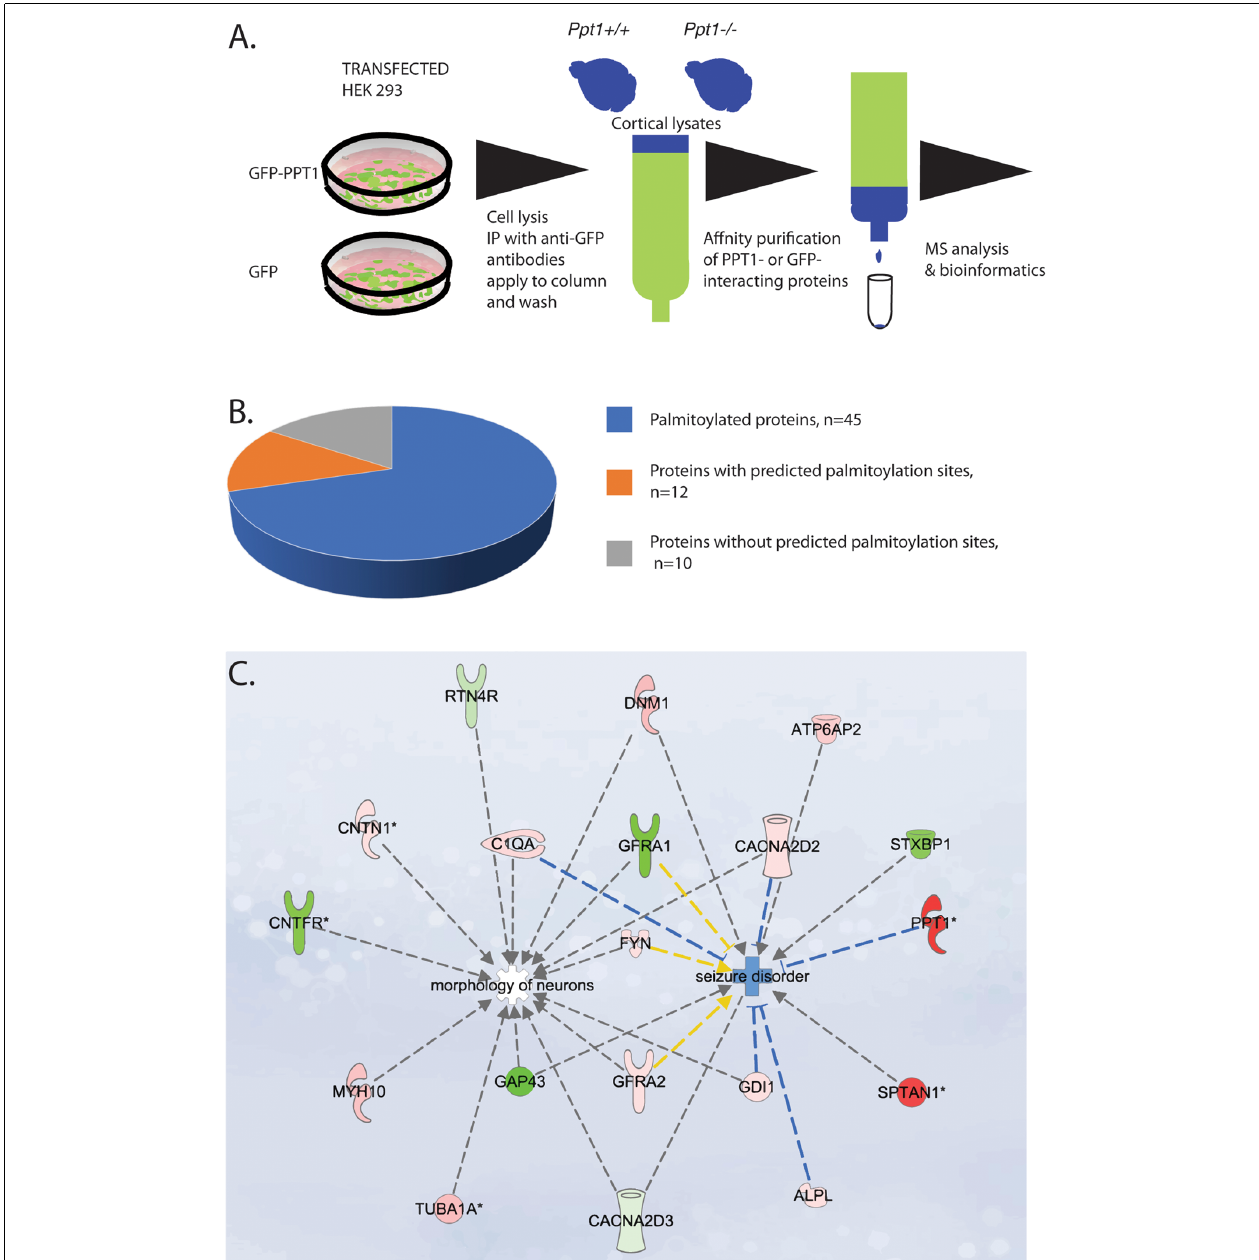
FIGURE 1 | (A) Schematic presentation of the proteomics work flow. From left to right: HEK 293 cells were transfected with either GFP-PPT1 or GFP expression plasmids. Cell were lysed, cell lysates were immunoprecipitated with anti-GFP antibodies coupled to protein A/G beads. The beads were loaded onto a column, washed and then protein lysates from P0 cortices derived from either Ppt1+/+ or Ppt1 − / − were applied to the GFP- and to the GFP-PPT1- bound beads and then washed. The bound proteins were eluted. The samples were then subjected to MS. The list of the identified proteins was then subjected to bioinformatic analysis. (B,C) Characterization of palmitoyl-protein thioesterase 1 (PPT1)-interacting proteins. (B) Among the total of 64 PPT1 interacting proteins, all contain at least one cysteine residue, 45 (70%) are known to be palmitoylated, nine (14%) contain sites that are predicted to be palmitoylated. (C) Ingenuity pathway analysis revealed that the high confidence proteins may contribute to neuronal morphology and to seizures. Proteins colored in red were enriched in the fractions from Ppt1 − / − and proteins colored in green were enriched in fractions from wild-type. Note: the origin of PPT1 is from the HEK293 cells used for the initial immunoprecipitation.